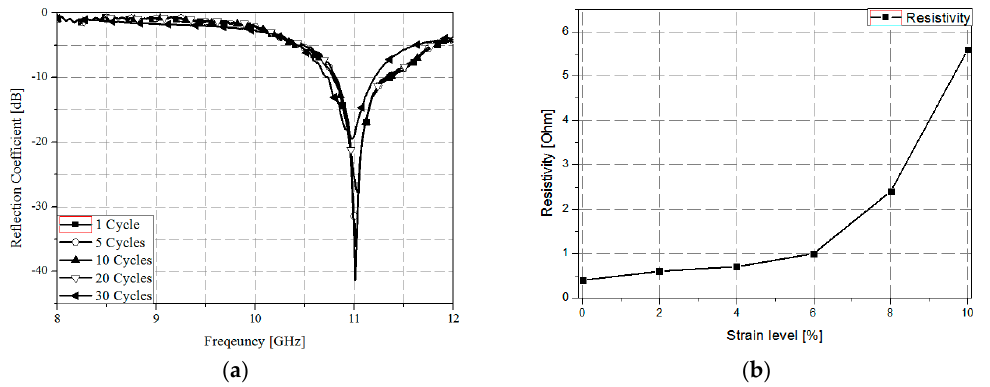
Figure 11. ( a ) Measured reflection coefficients after stretching for 30 cycles and ( b ) measured resistivity at different strain levels from 0 to 10%.